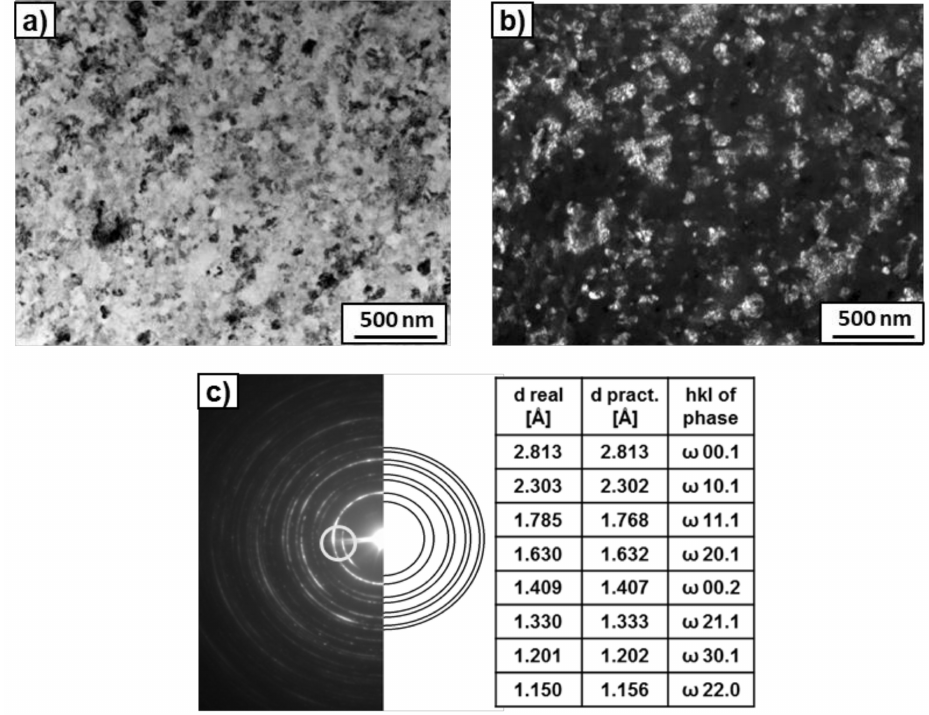
Figure 4. TEM micrographs of the Ti–3wt.% Nb alloy after HPT deformation and pre-annealing at 600 ◦ C. Bright field ( a ), dark field ( b ) images, as well as SAED pattern ( c ). The ring shows the position of the objective aperture for obtaining the dark-field image. The solutions are given in the table ( c ).